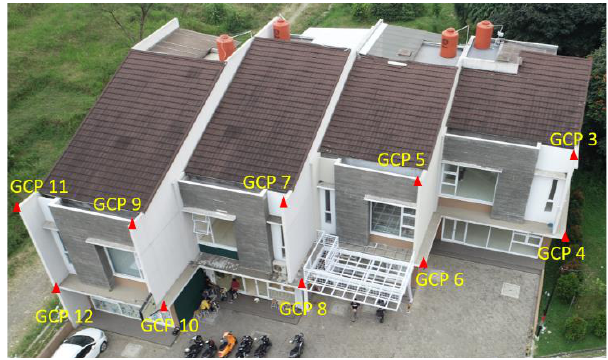
Figure 6. Ground Control Points (GCPs) location